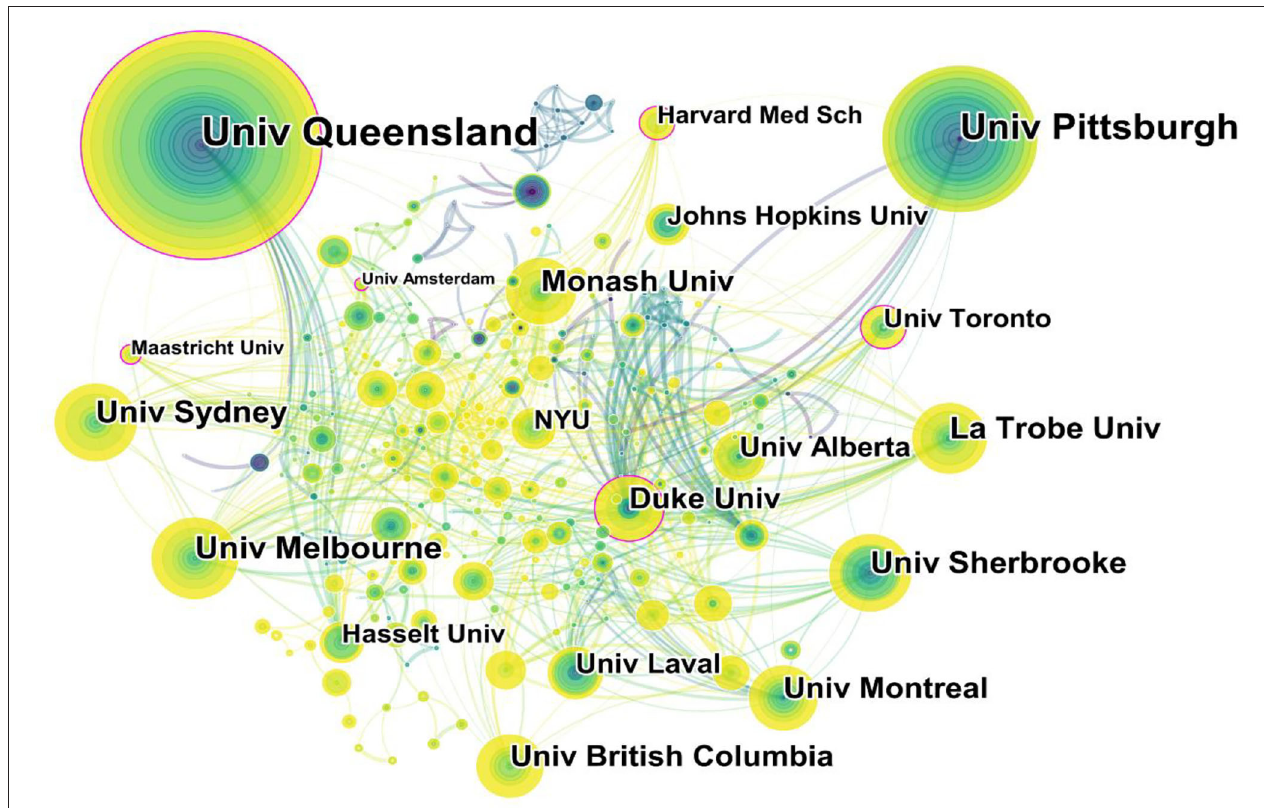
FIGURE 4 | Map of institutions researching telerehabilitation from 2000 to